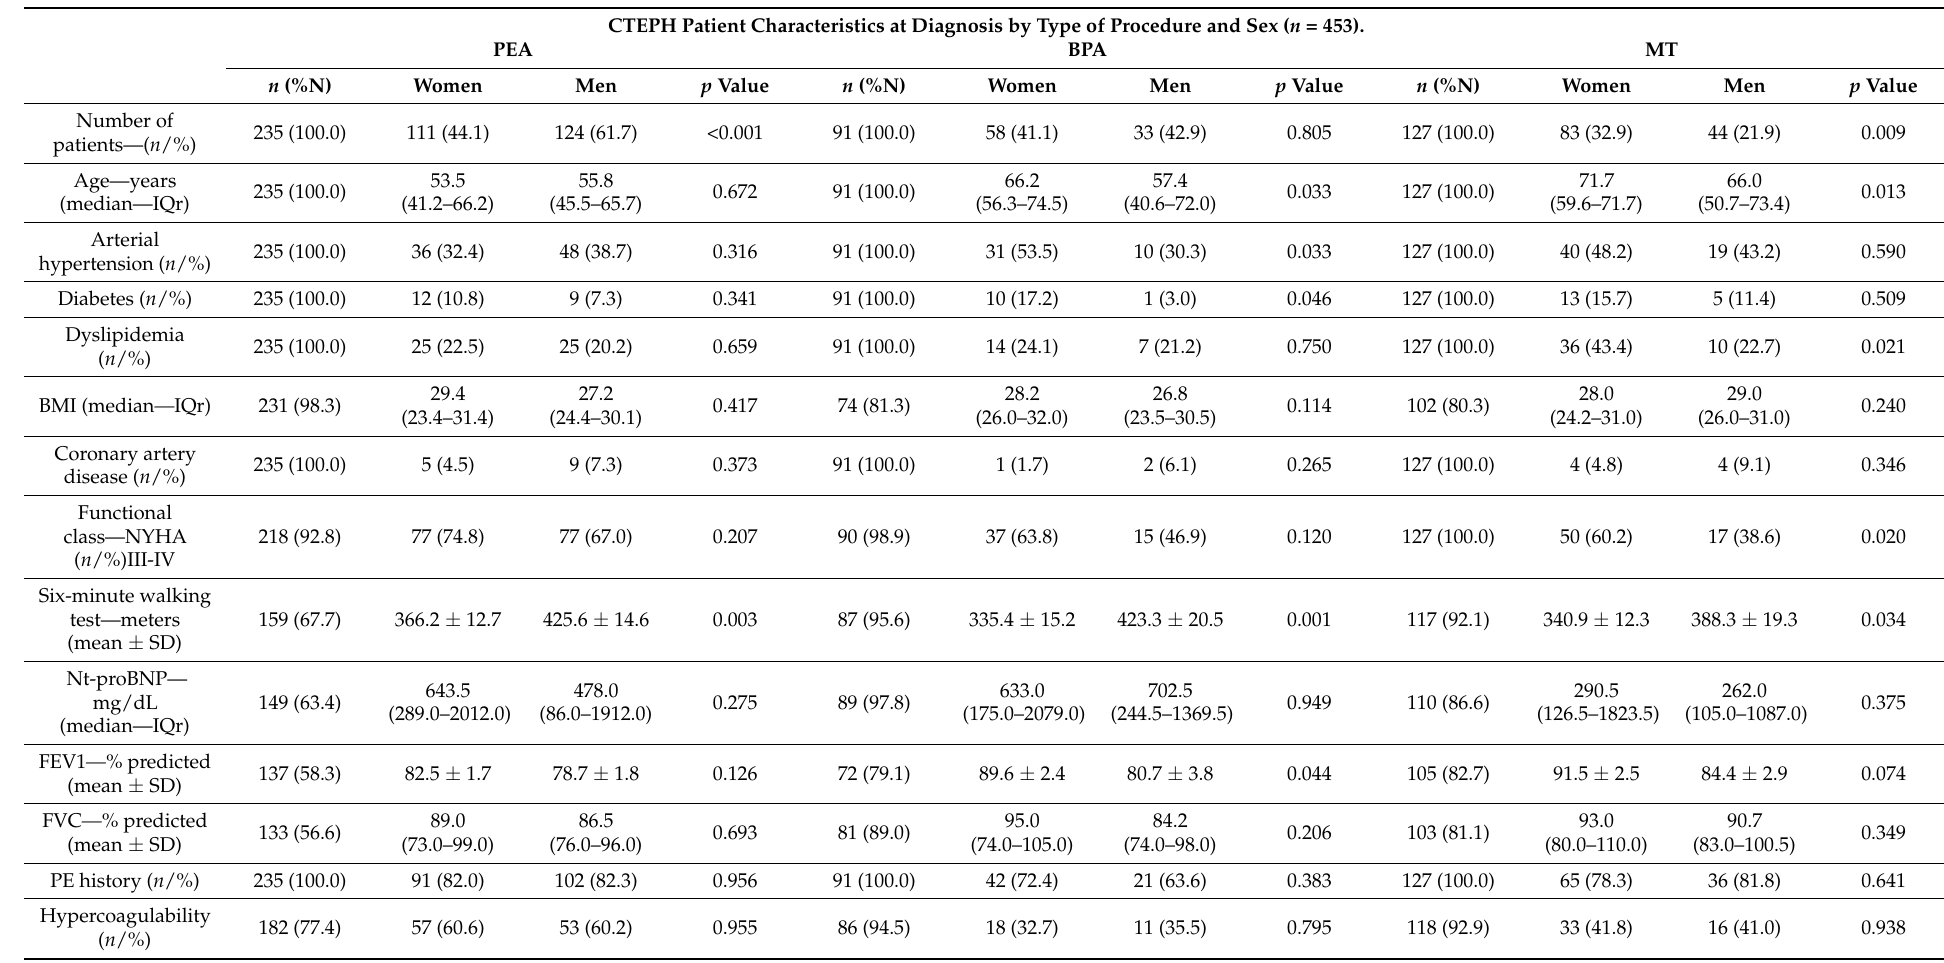
Table 1. CTEPH patient characteristics at diagnosis by type of procedure and sex. CTEPH Patient Characteristics at Diagnosis by Type of Procedure and Sex ( n = 453).